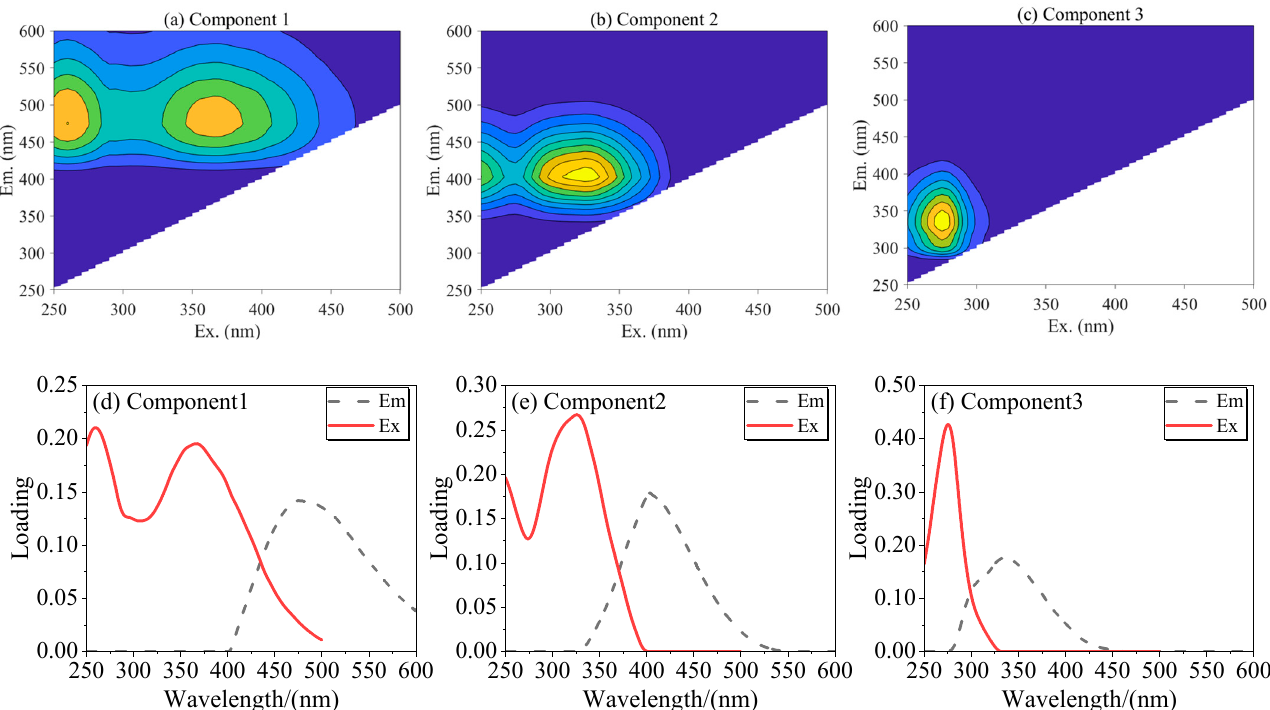
Figure 4. Identification of the three components extracted from the PARAFAC model. ( a – c ): contour plots of C1, C2 and C3. ( d – f ): excitation and emission loadings of C1, C2 and C3. Component1 (C1) demonstrated two fluorescence peaks at an E x /E m wavelength of 260 nm (365 nm)/475 nm, consistent with humic-like peaks, as previously reported [6,45]. Component2 (C2), with a primary fluorescence peak at an E x /E m wavelength of 325 nm/402 nm, was similar to fulvic-like acid in the visible region, a humus-like substance with a